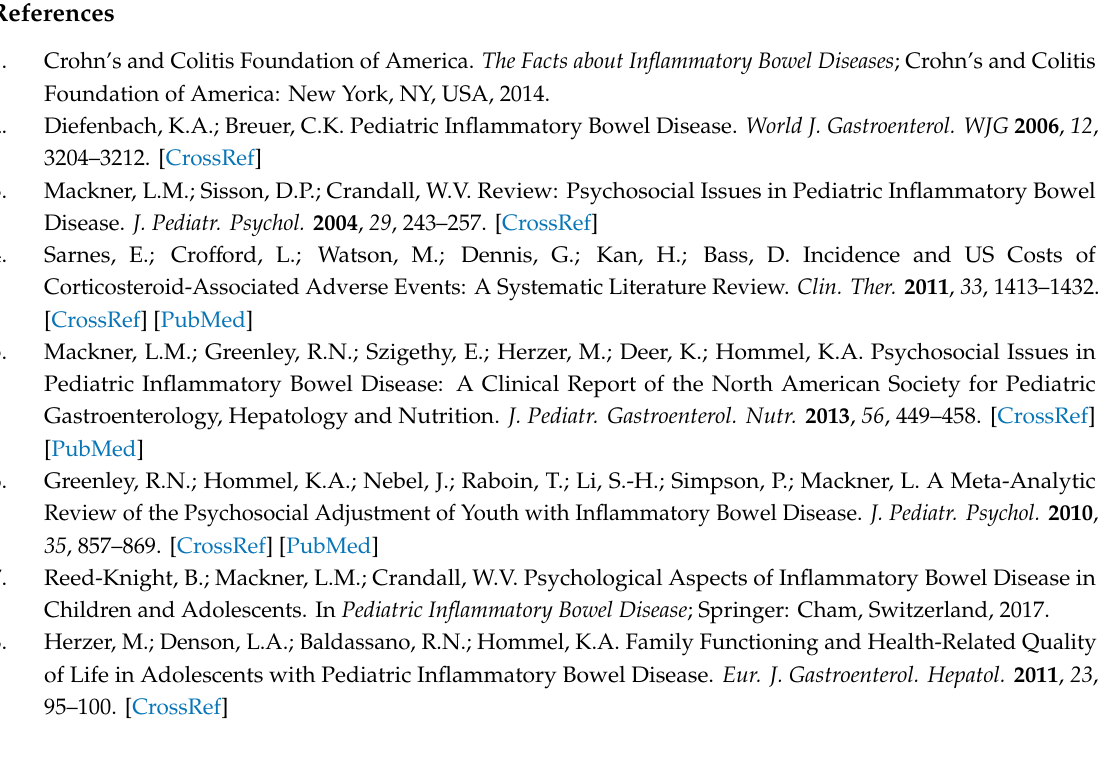
Table S1: Summary of